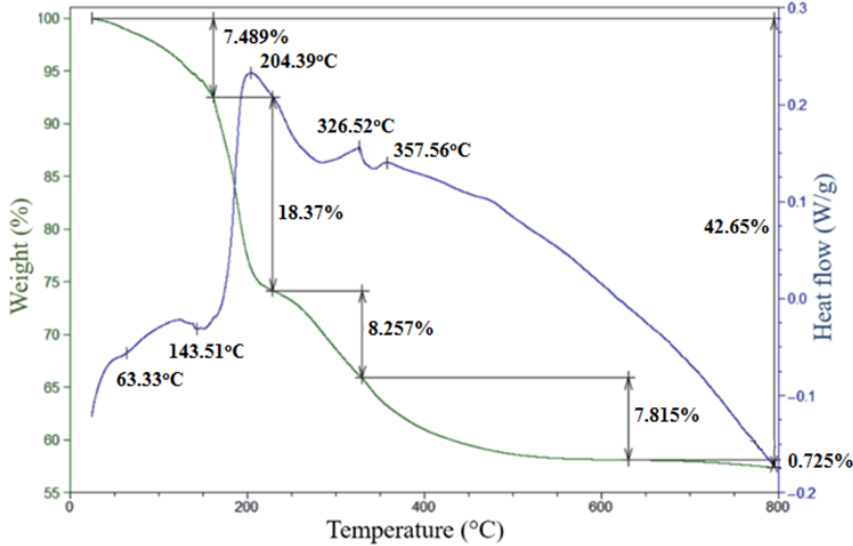
Figure 4. Thermogram of 2 · n H 2